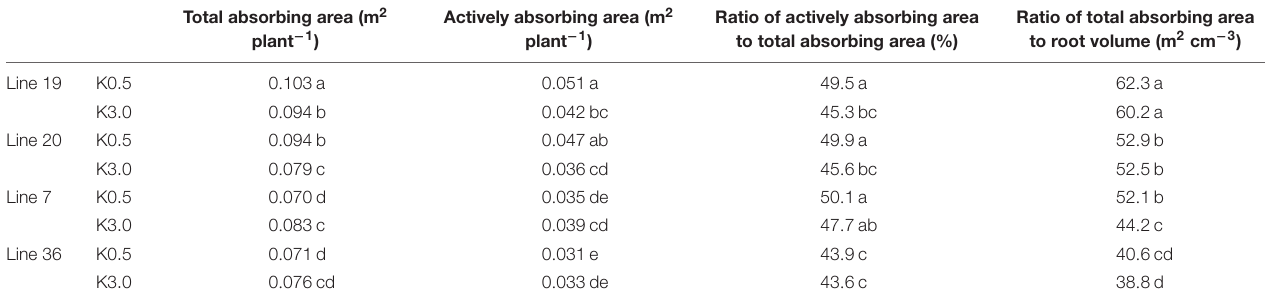
TABLE 3 | Root adsorption activity of vegetable soybean genotypes with different K efficiency.